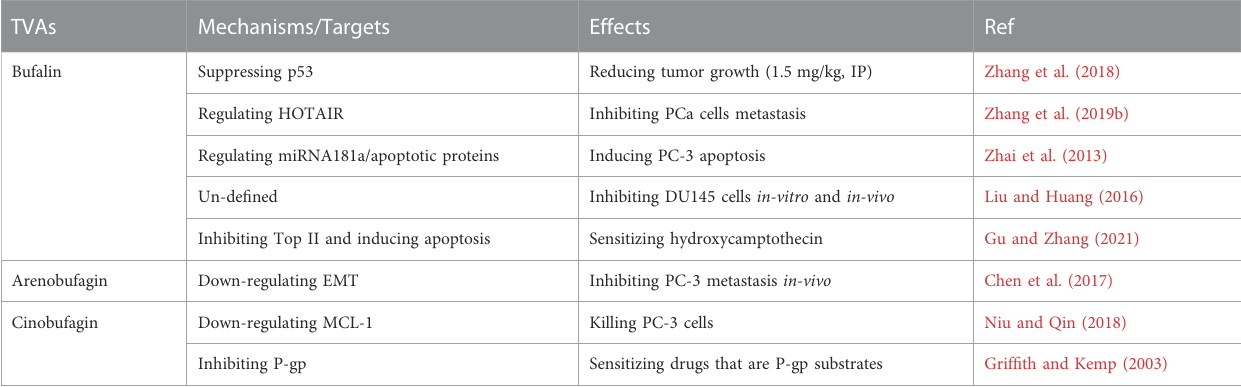
TABLE 1 Key facts of bufadienolides in the treatment of PCa (as of August 2022).